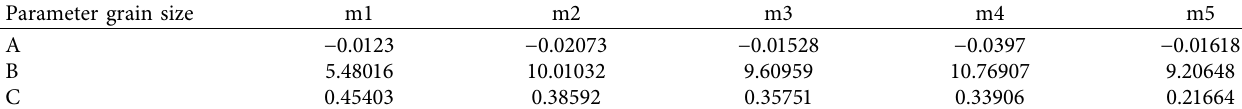
Table 4: Fitting parameter table of the first index decay of fragmentized coals with different grain sizes under the stress of 12MPa. Parameter grain